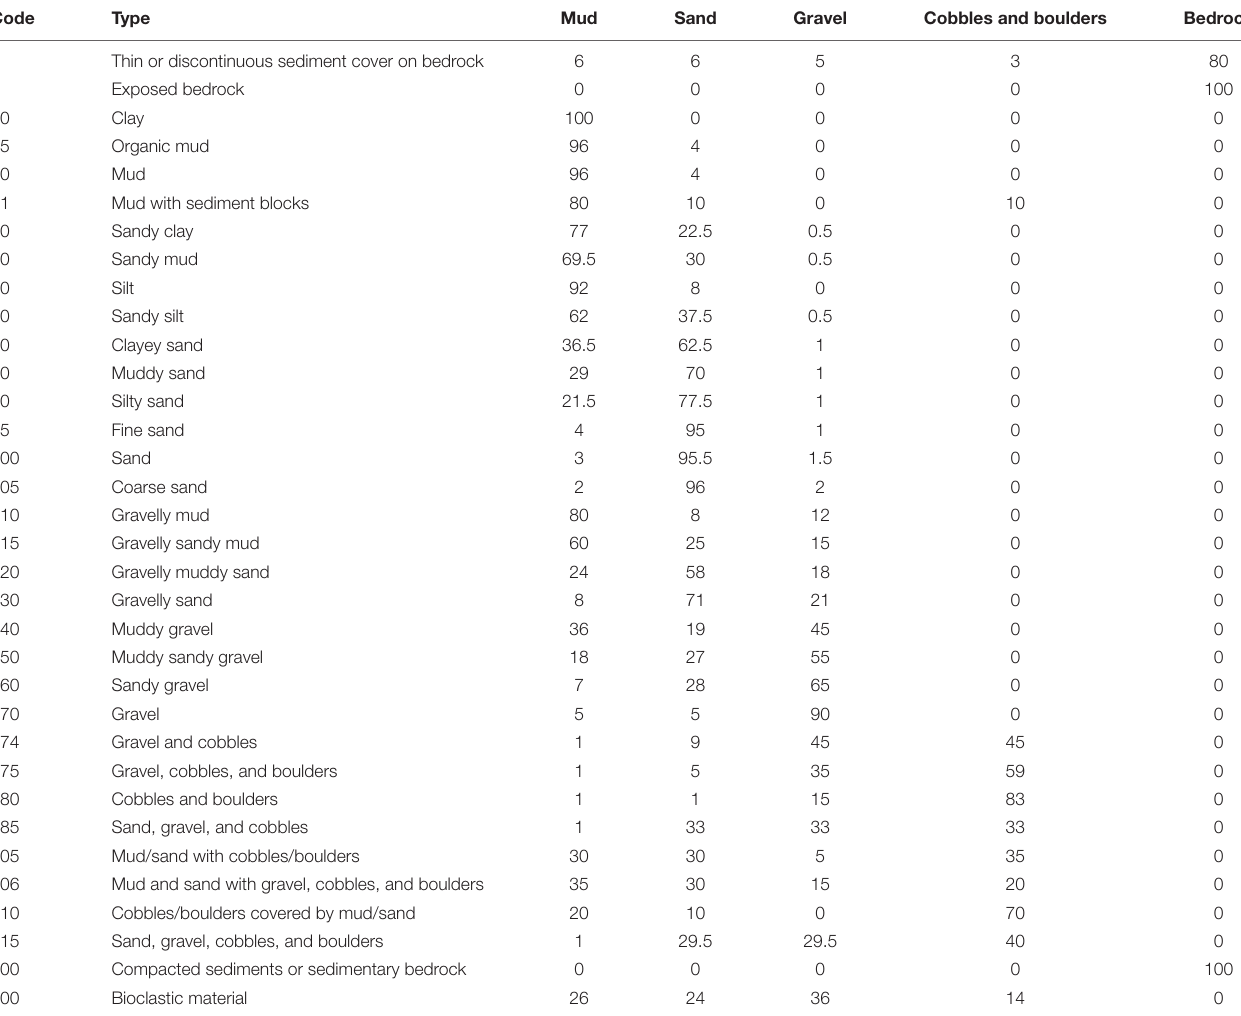
TABLE 1 | Lookup table provided by the Geological Survey of Norway (NGU) for conversion of categorical sediment grain size classes to continuous sediment